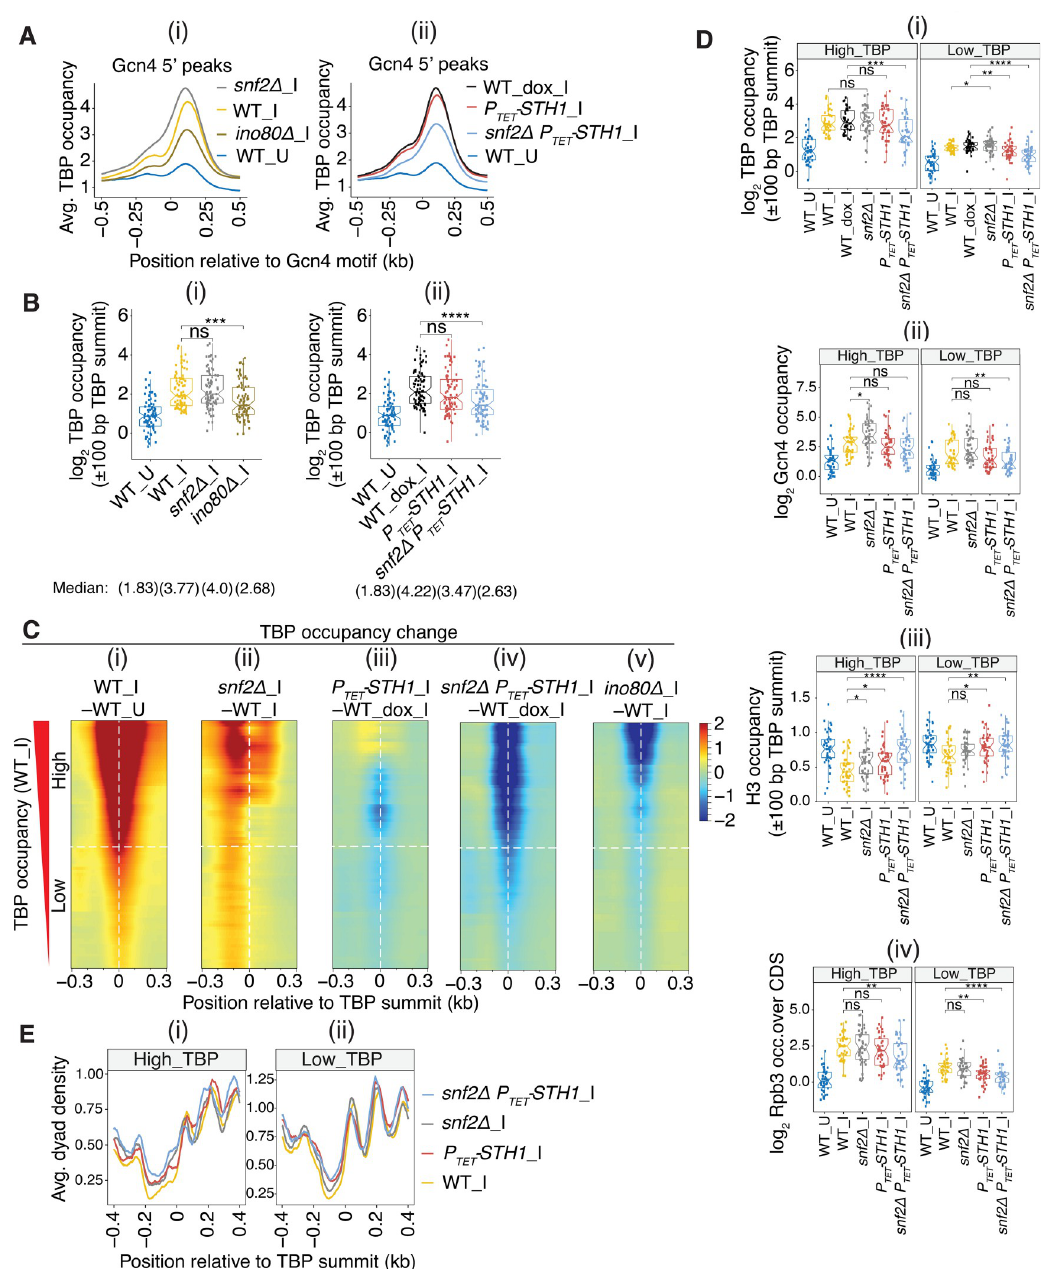
Fig 5. Reduced TBP recruitment in SWI/SNF and RSC mutants is frequently associated with increased +1 nucleosome occupancies in promoters of genes with 5’ Gcn4 binding sites. (A) (i)-(ii) Averaged TBP occupancies surrounding Gcn4 5’ motifs from ChIP-seq data of sonicated chromatin from at least 2 biological replicates of the indicated strains, with labels along the plots are arranged in decreasing order of summit heights. (B) (i)-(ii) Notched box plots of log 2 TBP occupancies measured within ± 100 bp of TBP peak summits identified by MACS2 peak analysis in the promoters of 83 of the 5’ Gcn4 target genes in the indicated yeast strains, color-coded as in (A). (C) Heat map depictions of differences in TBP occupancies surrounding TBP peak summits in the 83 5’ genes from (B) sorted in decreasing order of WT_I TBP levels in (i) WT_I vs. WT_U, (ii) snf2 Δ _I vs. WT_I, (iii) P I vs. WT_I, (iv) snf2 Δ P I vs. WT_I, and (v) ino80 Δ _I vs. WT_I, color-coded as indicated to the right. TET -STH1_ TET -STH1_ Two equal bins based on WT_I TBP of High_TBP or Low_TBP occupancies are indicated. (D) Notched box plots of factor occupancies in the 83 5’ gene promoters for the two bins defined in (C) for (i) log 2 TBP within ± 100 bp of TBP peak summits, (ii) log 2 Gcn4 at the respective Gcn4 peaks, (iii) H3 within ± 100 bp of the TBP peak summits, and (iv) log 2 Rpb3 within the CDS of target genes. (E) Average dyad density from H3 MNase-ChIP-seq data aligned to the TBP summits of the 83 5’ genes binned as in (C). Midpoints (dyads) of nucleosomal size sequences between 125 and 175 bp were averaged and plotted relative to the